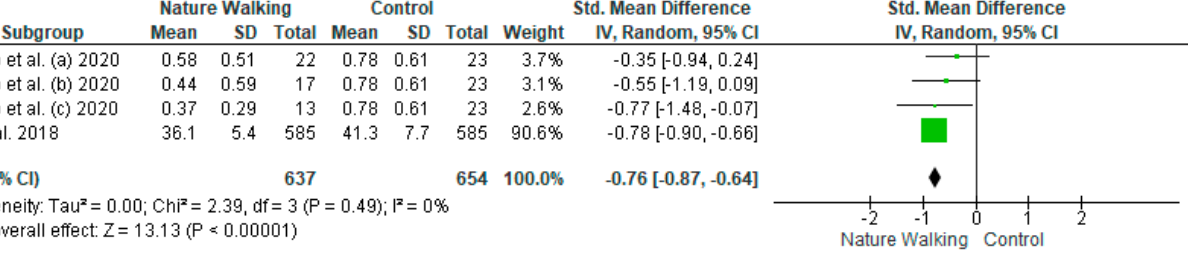
Figure 5. Anxiety Nature Walk vs. Control Forest Plot [11,13]. Green squares represent standardized mean difference for each study, while black rhombus represents the aggregated average of the standardized mean differences.